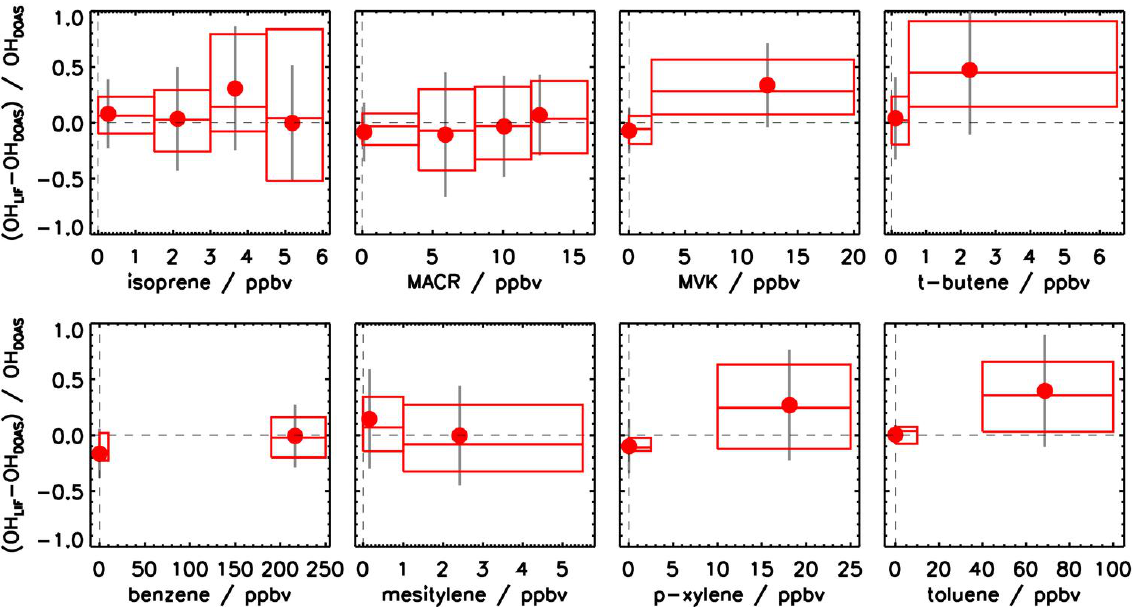
Fig. 6. Dependence of the relative difference between OH concentrations measured by LIF and DOAS on the VOC concentration measured over the course of the experiments. Red horizontal lines are the median and boxes give the 25 and 75 percentiles. Red dots are mean values with standard errors in grey bars. They are plotted at the mean of the VOC concentrations, which are analyzed within each